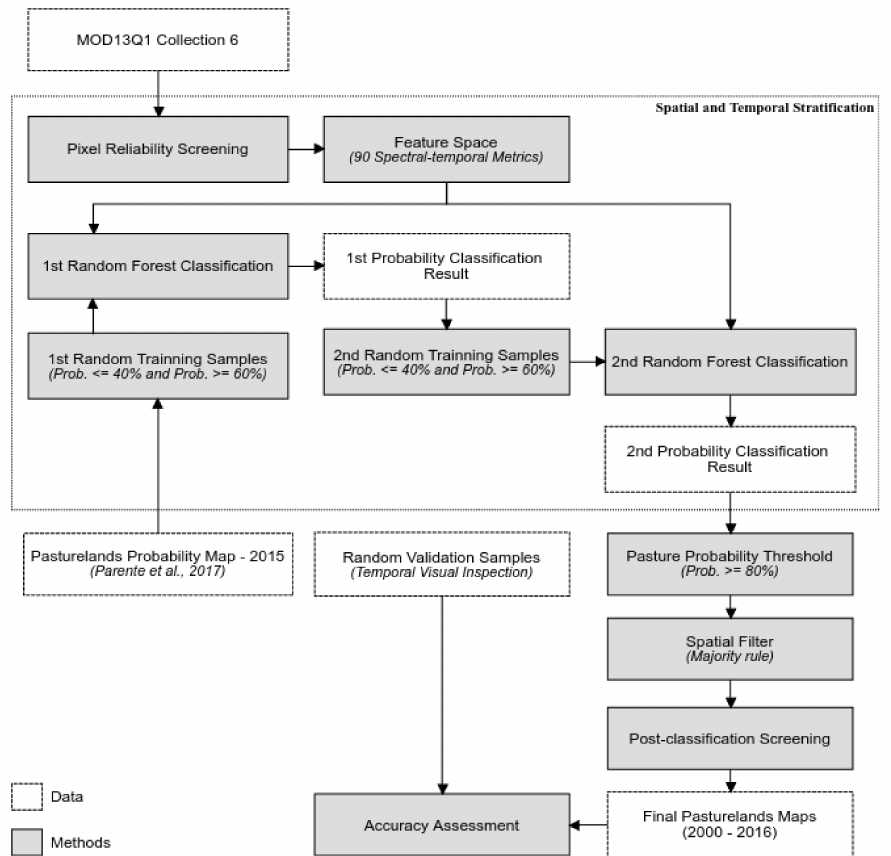
Figure 2. Methodological approaches used for mapping the Brazilian pasturelands between 2000 and 2016 based on MODIS data. The geographic stratification was based on the useful limits of the Landsat WRS-2 tiles, while the temporal stratification considered a calendar year